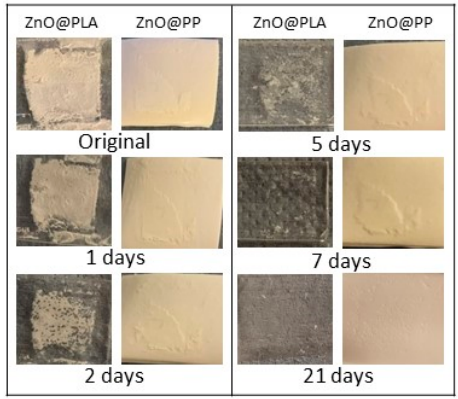
Figure 13. ZnO@PLA and ZnO@PP samples after different time intervals in artificial urine solution.